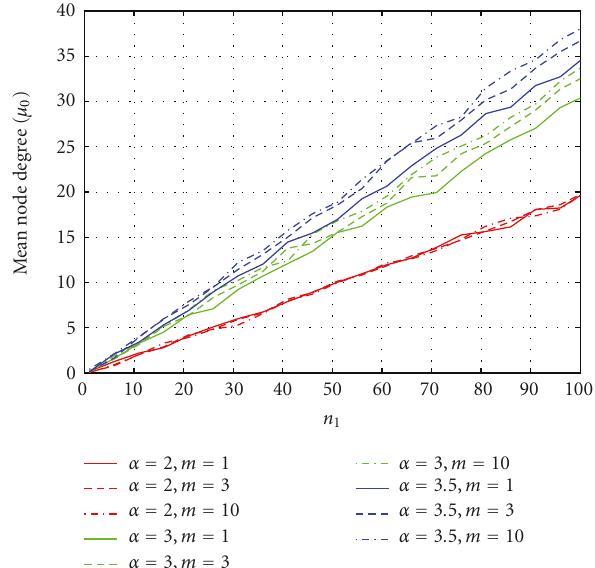
Figure 9: Simulated mean node degree in Nakagami- m channels as a function of the relative node